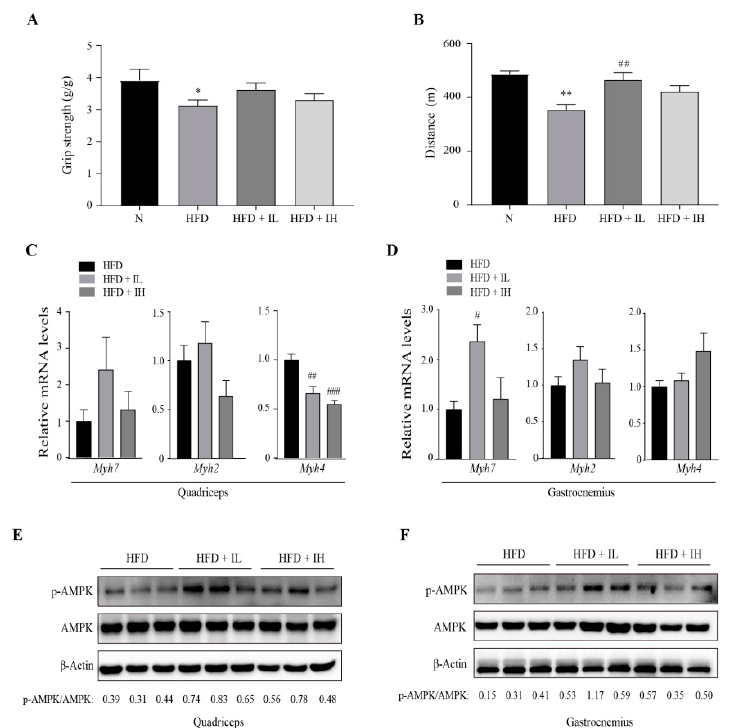
Figure 4. Effects of IJE on muscle exercise endurance capacity in HFD-induced obesity mice. Results of the ( A ) grip strength and ( B ) treadmill tests. ( C , D ) Relative mRNA expression levels of Myh7 , Myh2 and Myh4 in the quadriceps and gastrocnemius muscles ( n = 6). ( E , F ) Protein level of phosphorylated AMPK in the muscles. Data are presented as mean ± SEM. * and ** indicate p < 0.05 and 0.01, respectively, when compared to the N group. # indicates p < 0.05, ## indicates p < 0.01, and ### indicates p < 0.001 when compared to the HFD group. HFD, high-fat diet; HFD+IL, HFD+IJE 0.25% of diet; HFD+IH, HFD+IJE 0.5% of diet; N, normal diet.